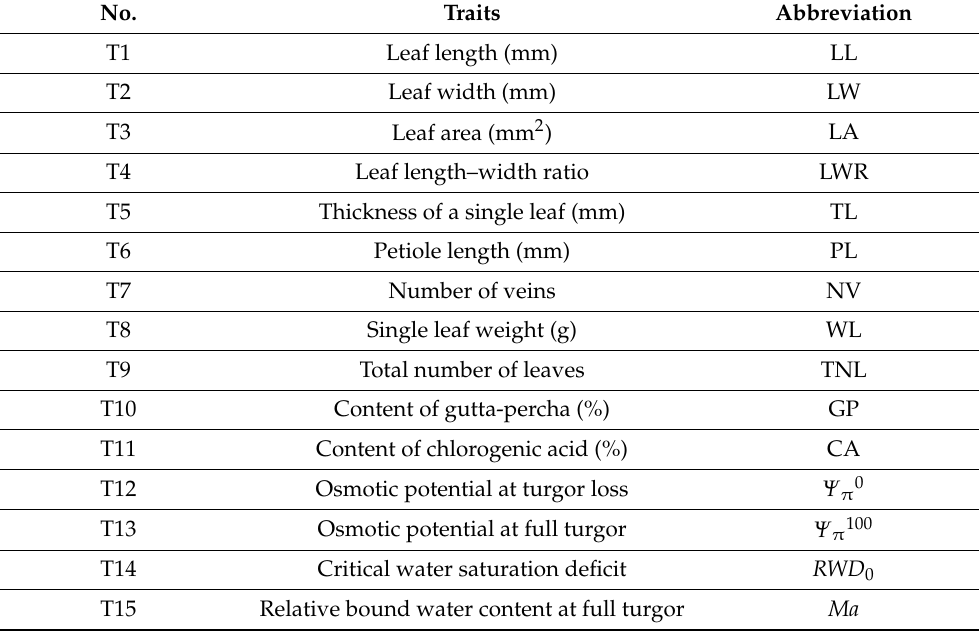
Table 1. Leaf-related traits of Eucommia ulmoides Oliver in the current study. No.